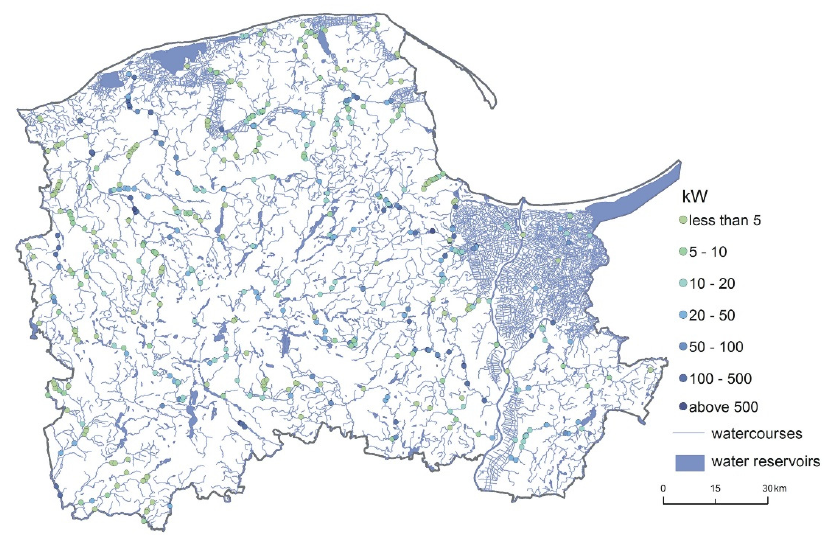
Figure 16. Localization of water dams and power of the potential hydropower plants in the Pomorskie voivodeship (own elaboration). is 22.1 MW (Figure 17).